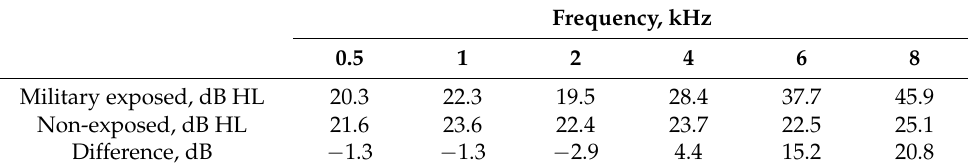
Table 6. Mean HTLs obtained by Xiong, Yang, Lai and Wang [28] for a military noise-exposed group and a non-exposed group. The bottom row shows the difference in HTLs between the two groups at each frequency.